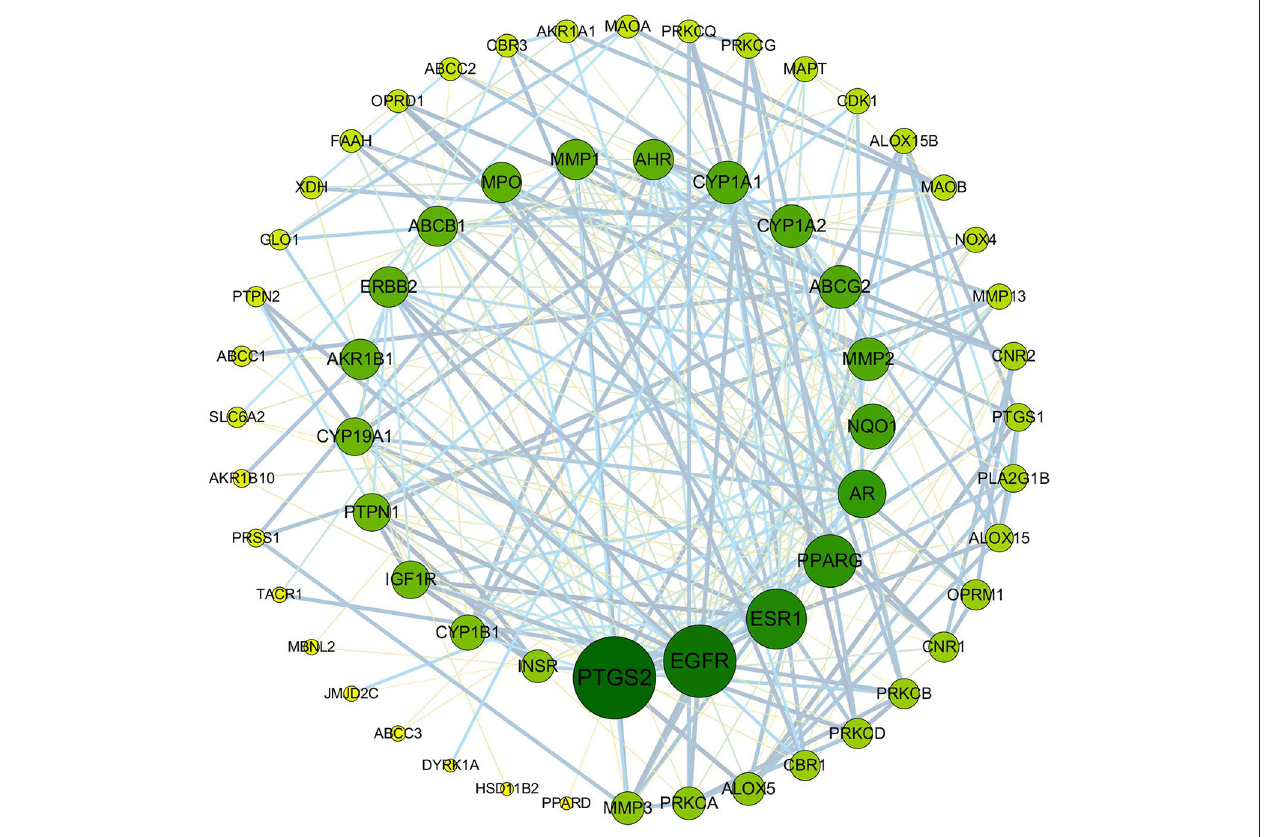
FIGURE 6 | PPI network of anti-oxidative targets of L. aureum . The potential targets are represented by the nodes, and the interactions between targets are represented by the edges. The larger degree of targets was indicated by the color from dark to light and the size from big to small. The combined score of targets was indicated by the thickness of